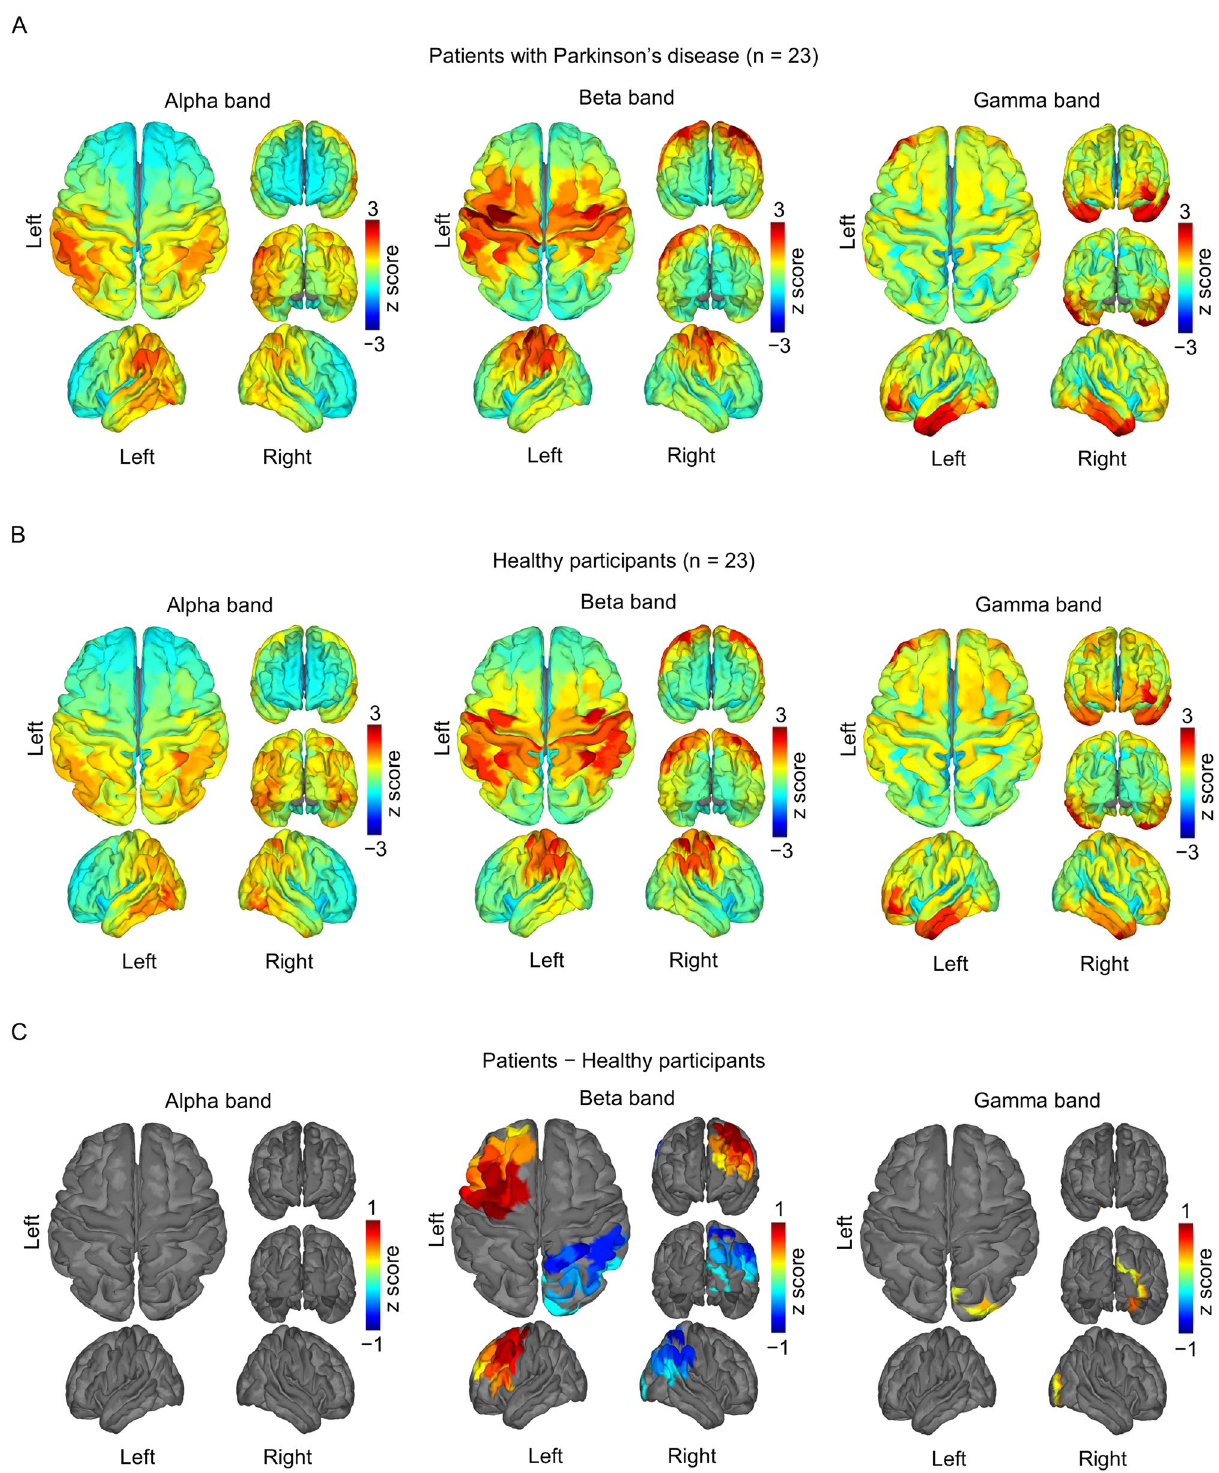
Figure 4. Cortical power during the resting state. The normalized power of 3 frequency bands (alpha, beta, and gamma) was averaged for ( A ) the patients with Parkinson’s disease (n = 23) and ( B ) the healthy study participants (n = 23) and was color-coded for each cortical area. ( C ) The differences in mean power between the participant groups ( A , B ) were color-coded for the participants’ cortical areas with statistically significant